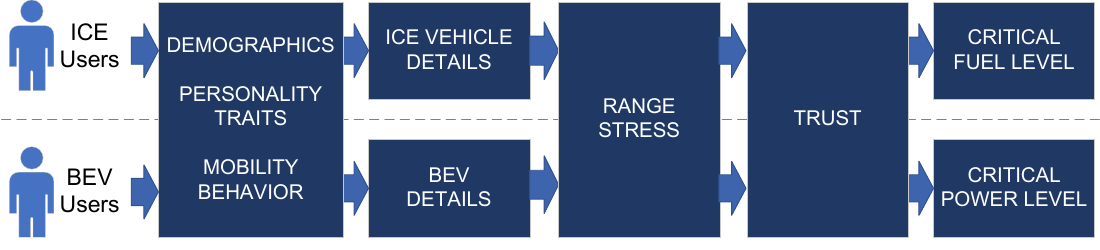
Figure 1. Questionnaire structure with between-group design.